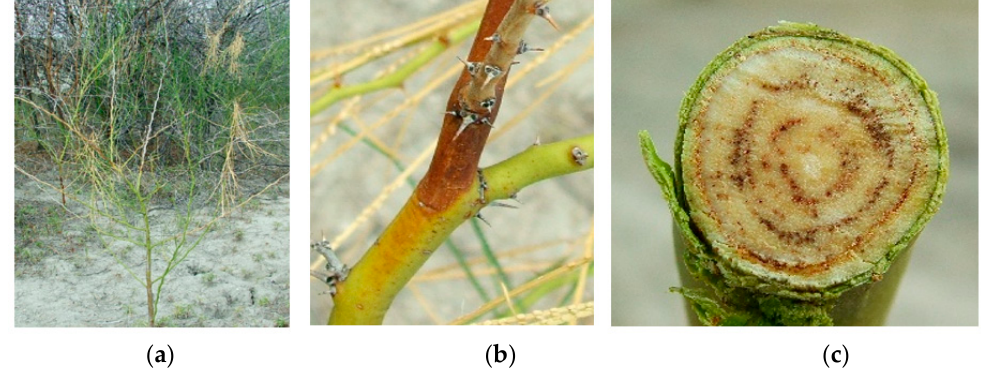
Figure 1. Typical symptoms of dieback on Parkinsonia aculeata . Dieback affected plant ( a ); Dieback lesion moving from tip to a position lower on the branch ( b ); Stem vascular bundle staining ( c ).